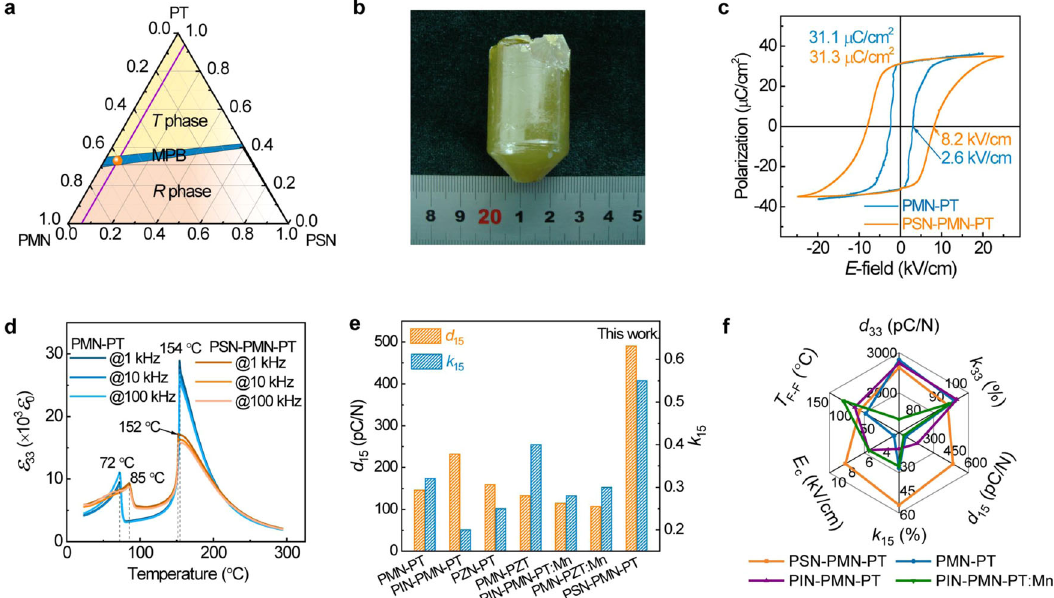
Fig. 2 Functional characterizations of PSN – PMN – PT single crystals. a Phase diagram of the PSN – PMN – PT ternary system. The blue area indicates the MPB region of the PSN – PMN – PT system. The orange point indicates the composition of our sample, 0.06PSN – 0.61PMN – 0.33PT, which is intensively investigated herein. b Photograph of the as-grown PSN – PMN – PT crystals, showing a large dimension of Φ 25×35mm 3 . c P – E loop of 0.06PSN – 0.61PMN – 0.33PT in comparison with that of 0.67PMN – 0.33PT. d Temperature dependence of the relativity dielectric permittivity of the two crystals. 0.06PSN – 0.61PMN – 0.33PT exhibits a comparable Curie temperature T C but a markedly improved T F – F than 0.67PMN – 0.33PT. e Shear piezoelectric performance of various [001] C -poled relaxor-PT crystals with MPB composition, demonstrating that 0.06PSN – 0.61PMN – 0.33PT exhibits signi fi cantly superior d 15 and k 15 . f Comparison of the essential parameters for various [001] C -oriented PbTiO 3 -based relaxor ferroelectric single crystals with MPB composition. The 0.06PSN – 0.61PMN – 0.33PT crystals cover the largest area, denoting a superior overall performance. Data from refs. 22, 66, 67 , and this